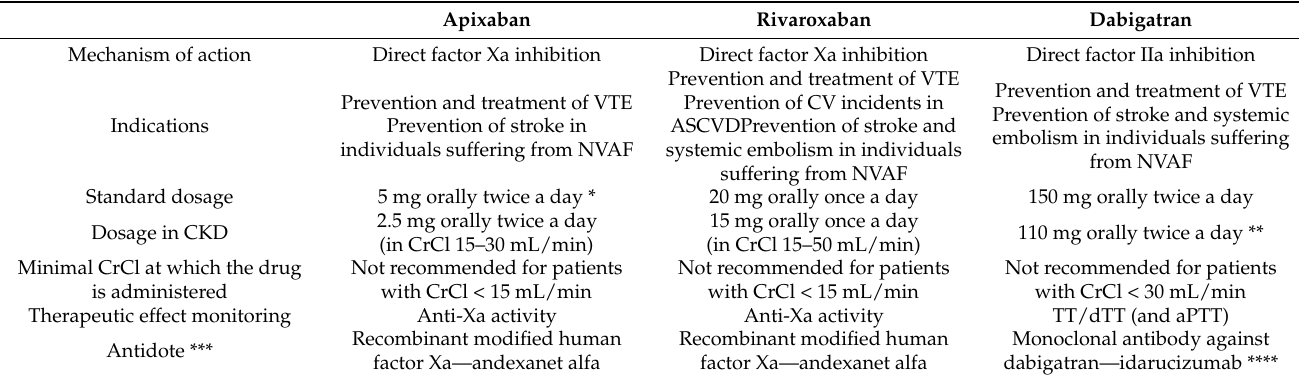
Table 1. Essential clinical information on the use of